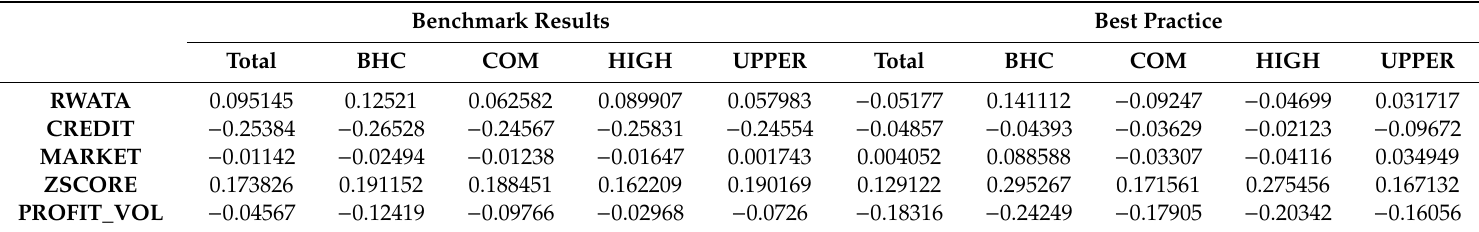
Table 6. Predicted Benchmark and Best Practice Results across Risk Measurements and Samples. Benchmark